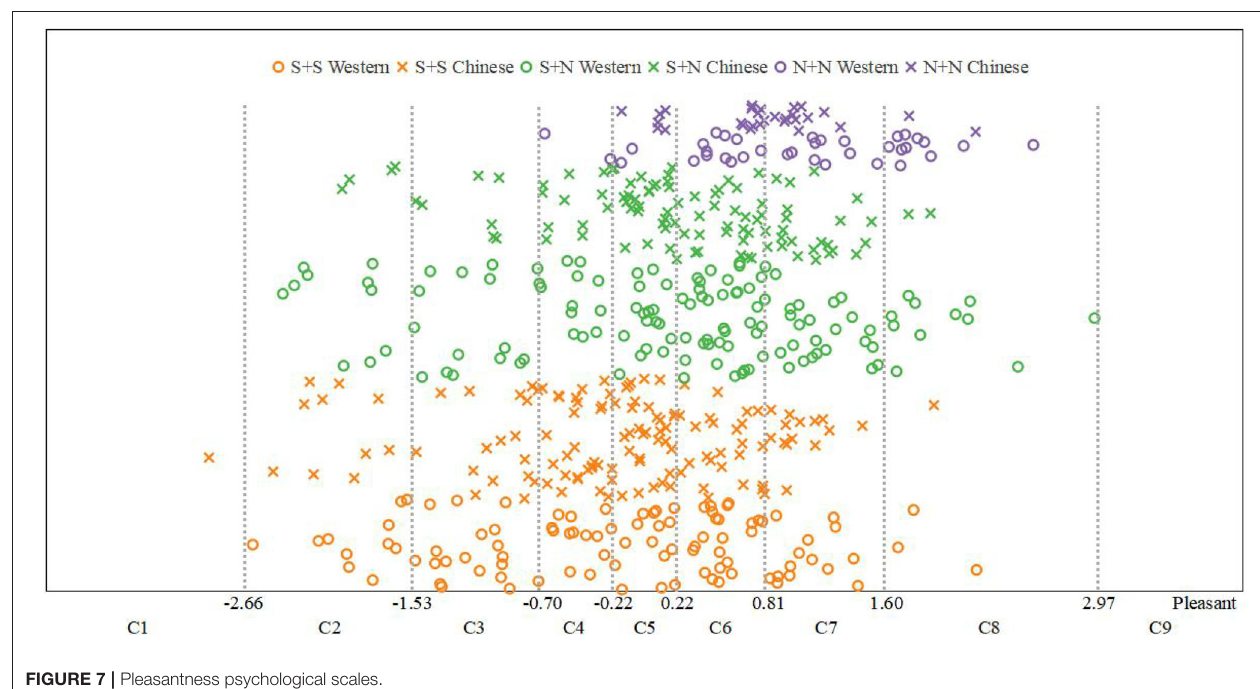
FIGURE 7 | Pleasantness psychological scales.